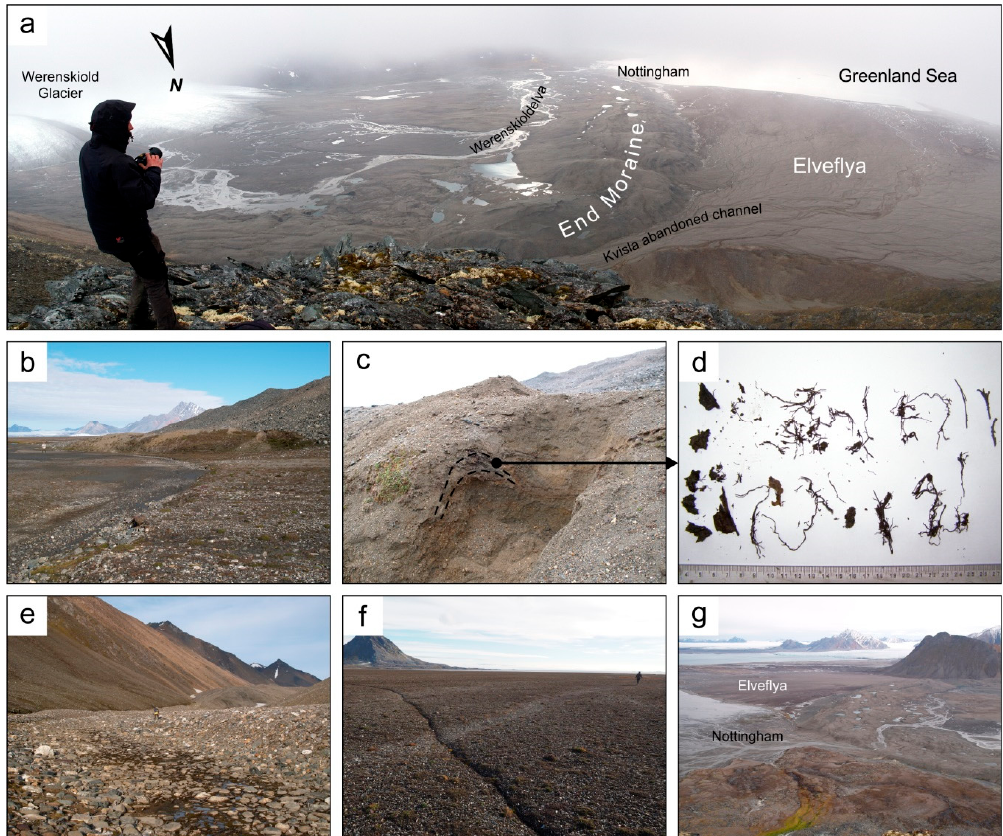
Figure 3. Landforms in the research area: ( a ) panoramic (distorted) view from the Mt. Jens Erik, ( b ) the biggest push moraine in the front of the Werenskiold Glacier end moraine, ( c ) cross-section of the push moraine with a raised and deformed layer of fossil tundra, ( d ) fossil tundra in examples of Saxifraga and Salix polaris collected from deformed layer visible in the photo c, ( e ) the upper part of the Elveflya fan and abandoned channel of the Kvisla river, ( f ) linear cracks on the Elveflya surface, and ( g ) view from the South to the North.